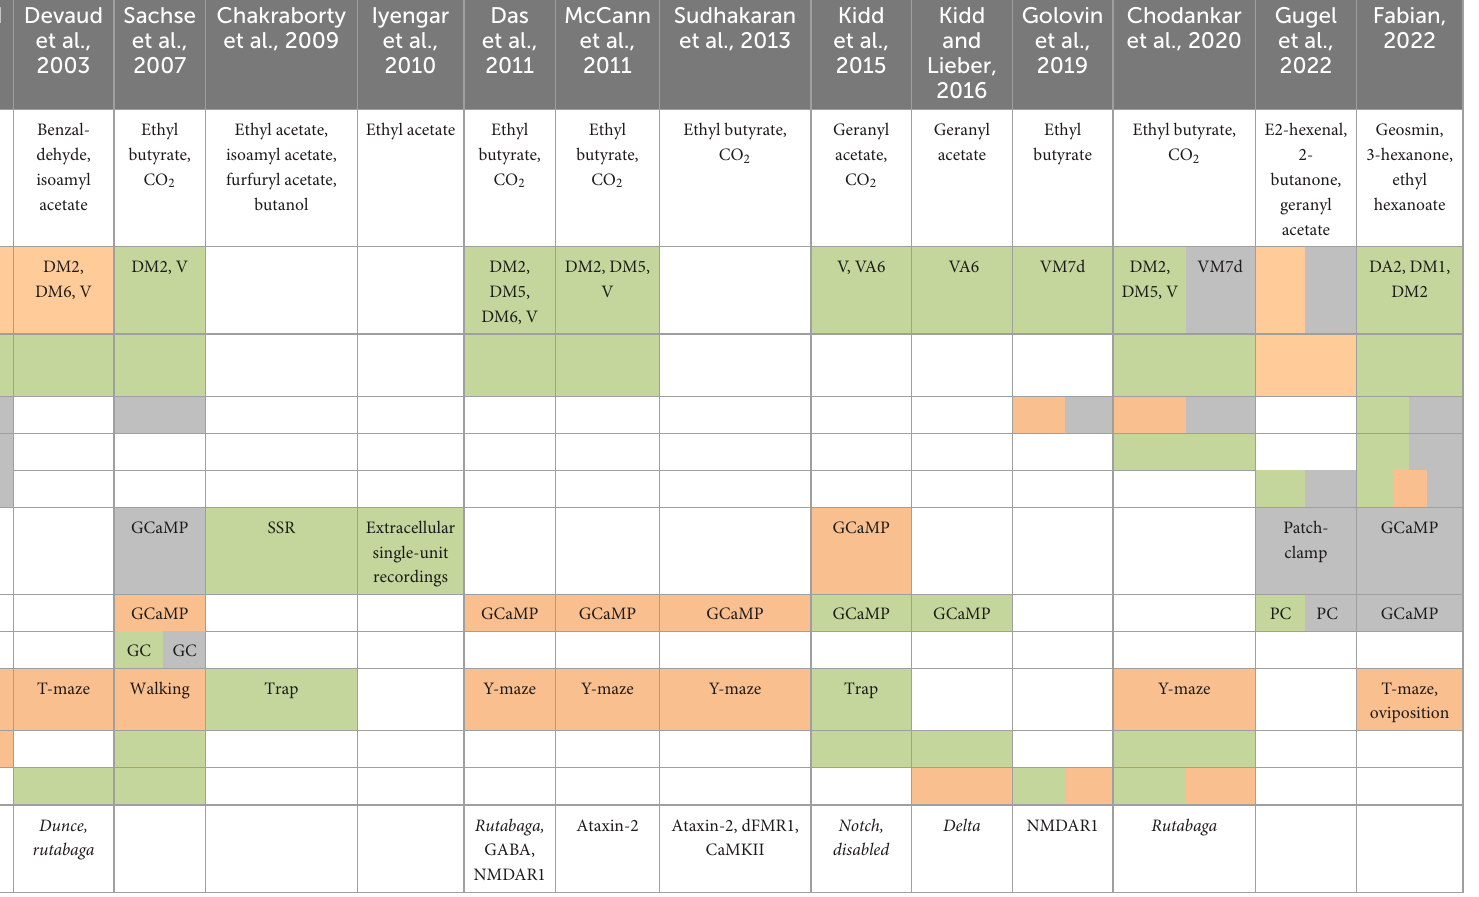
TABLE 1 Summary of the literature on experience-dependent plasticity in the olfactory system of Drosophila melanogaster using long-term odor exposure.